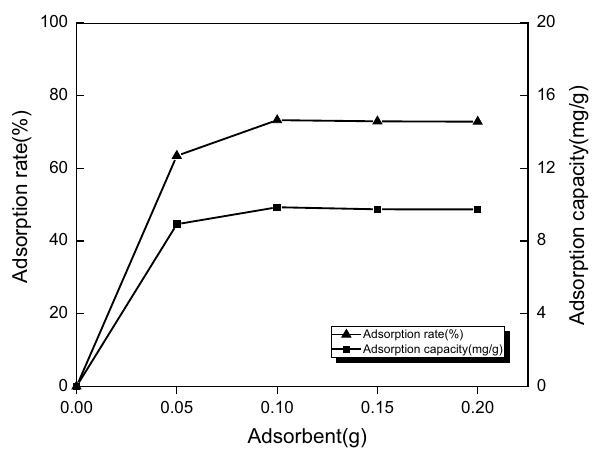
Fig. 6 Effect of adsorbent dosage on cadmium(II) adsorption; C pH = 5.0, Cd 2 + = 1.0 mg/mL, t = 40 min, T = 25 °C